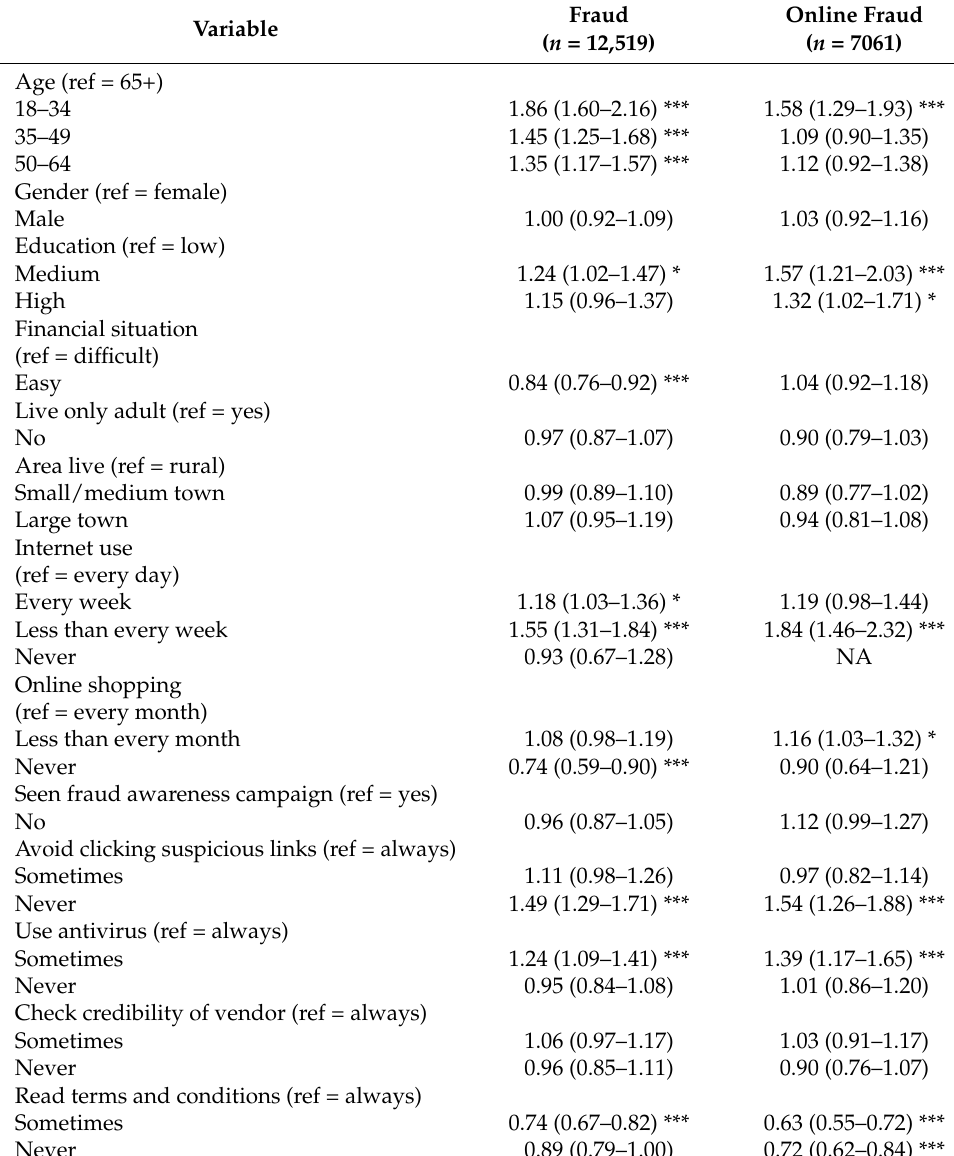
Table 10. Odds ratios and 95% CI for financial impact from fraud and online fraud